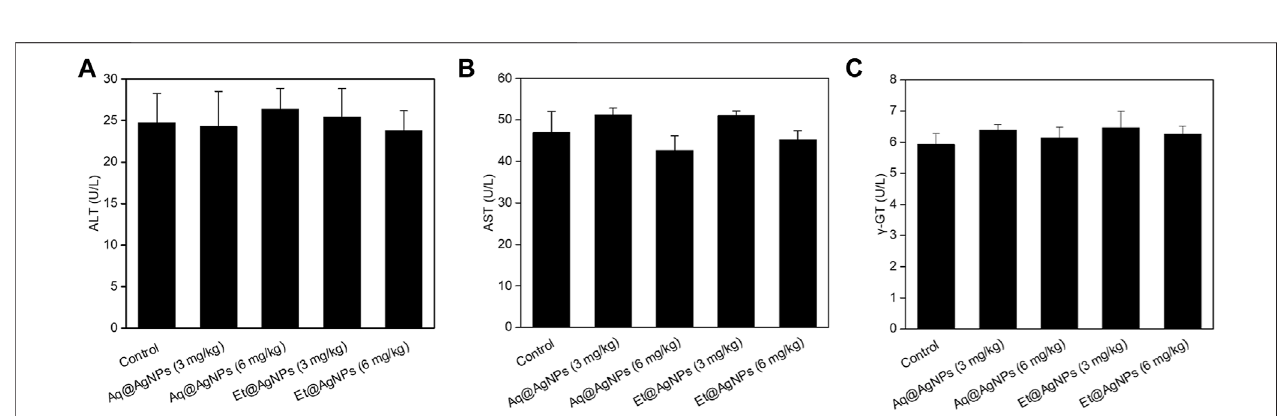
FIGURE 6 | Liver function biomarkers of bAgNPs-treated rats. Serum (A) alanine aminotransferase (ALT), (B) aspartate aminotransferase (AST), and (C) gamma- glutamyl transferase ( γ -GT) were measured as liver function biomarkers. Two different doses (i.e., 3 and 6 mg/kg) of both Aq@AgNPs and Et@AgNPs were injected throughintravenousroute.Nosigni fi cantdifferencewasobservedinOne-wayANOVAtestwhentreatmentgroupswerecomparedwiththatofthecontroland p > 0.05.